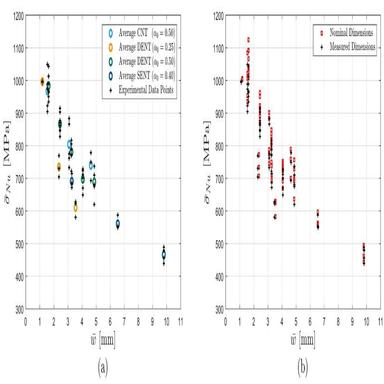
(a) Variation of the intrinsic nominal strength with intrinsic characteristic size for all the tested specimens; (b) comparison of the individual specimen data points, plotted using both their nominal and measured dimensions.